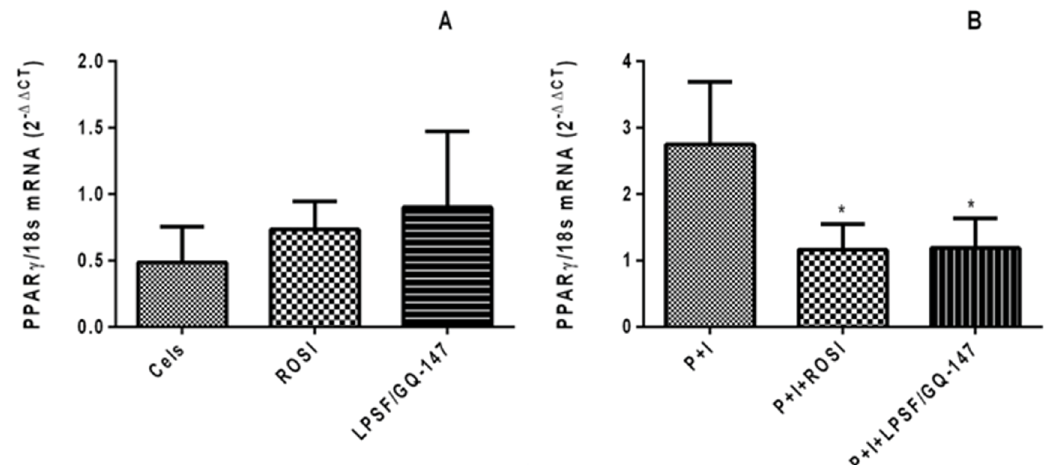
FIGURE 4 - PPARγ18s mRNA ratio in PBMCs from healthy individuals. A. PPARγ mRNA in cells treated with Rosiglitazone and LPSF/GQ-147 compound at concentration of 100 µM. B. Iono and PMA enhance PPARγ expression and its agonists reduce significantly PPARγ mRNA antagonizing the effects of Iono and PMA